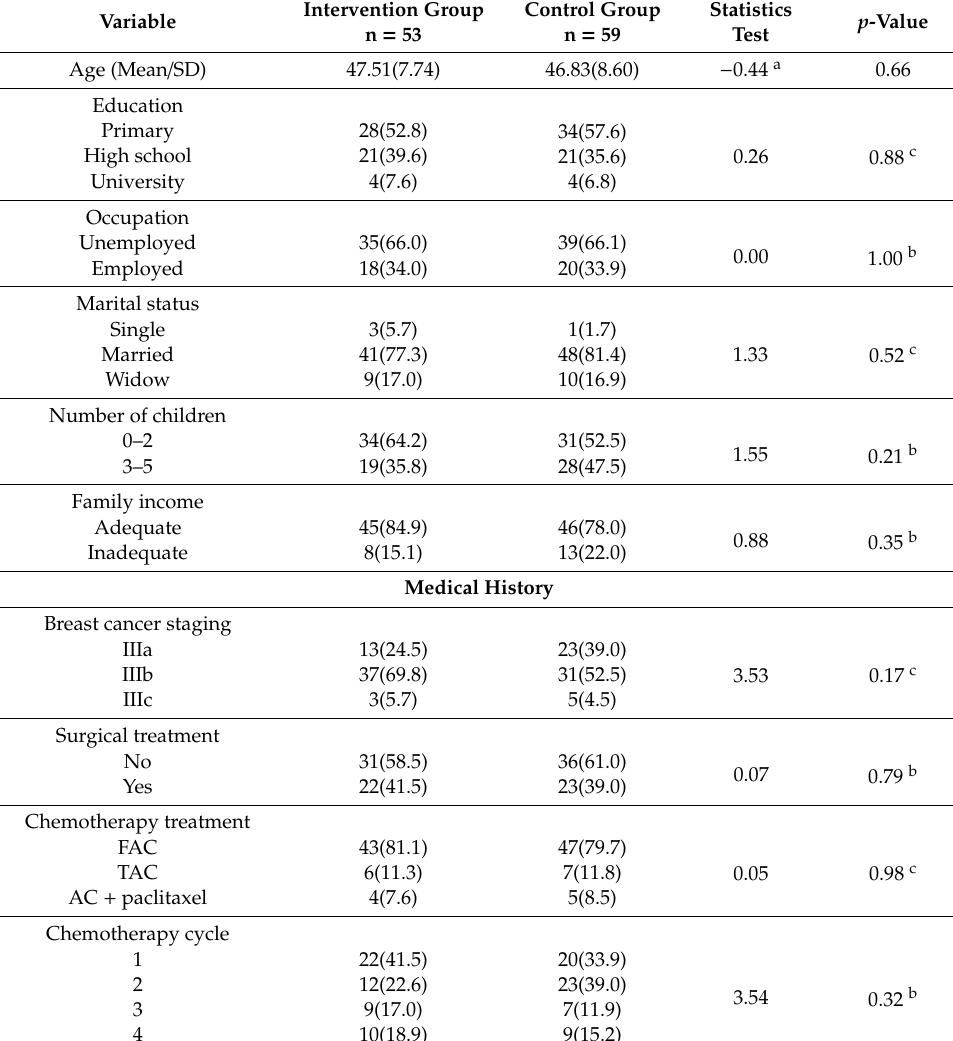
Table 1. Comparison of participants’ demographic information between the intervention (n = 53) and control (n = 59)